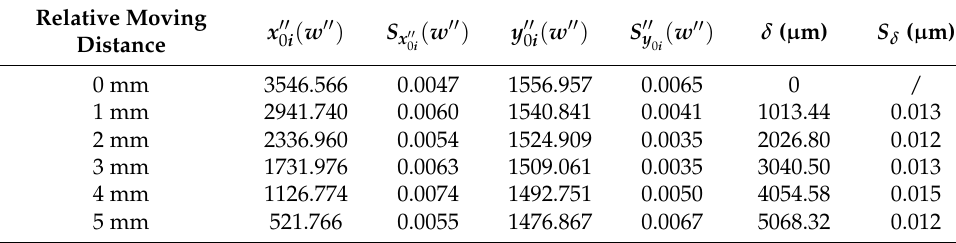
Table 6. Large range displacement experiment result at 5 mm ( i best =